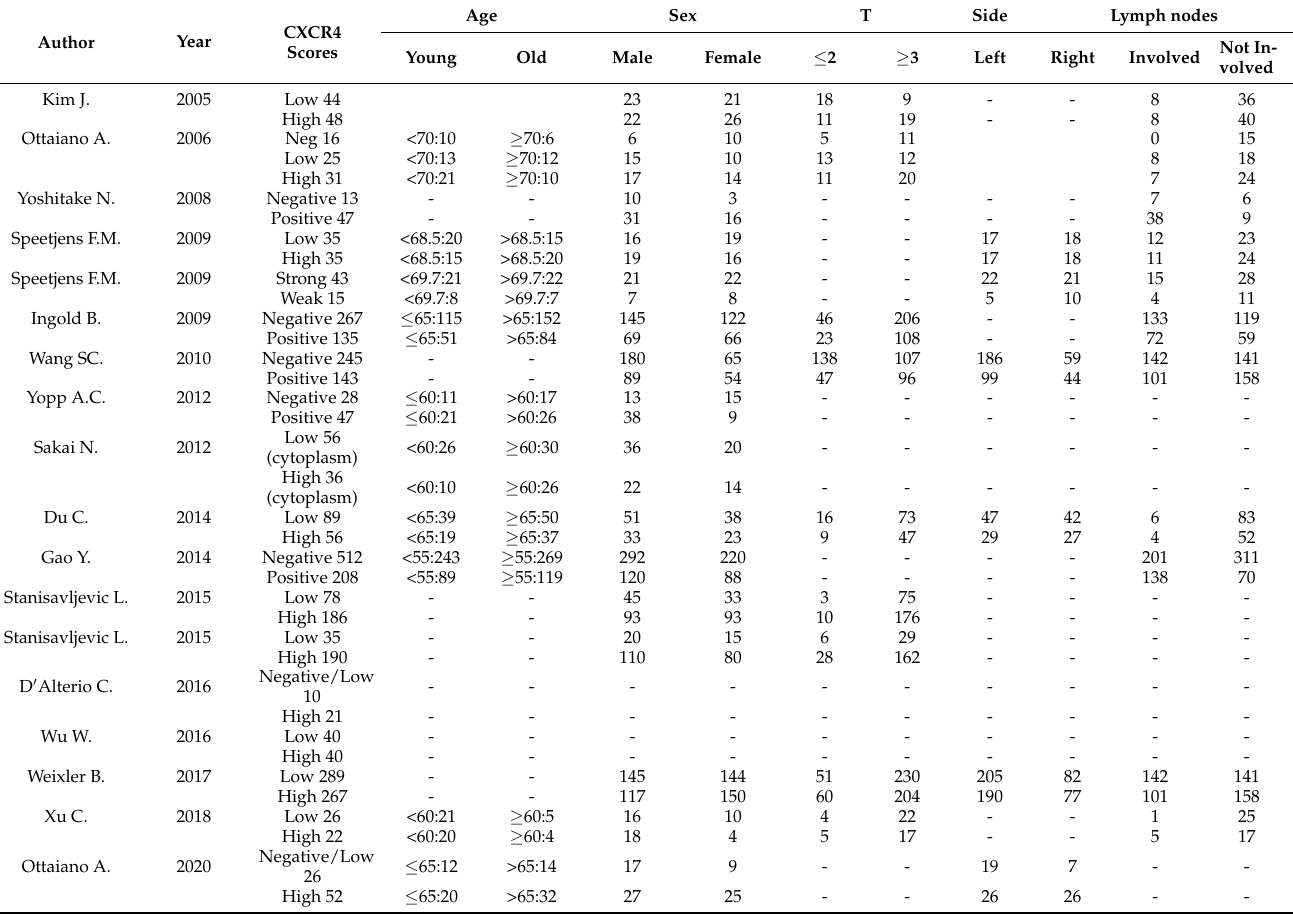
Table 2. Clinico-pathological characteristics according to CXCR4